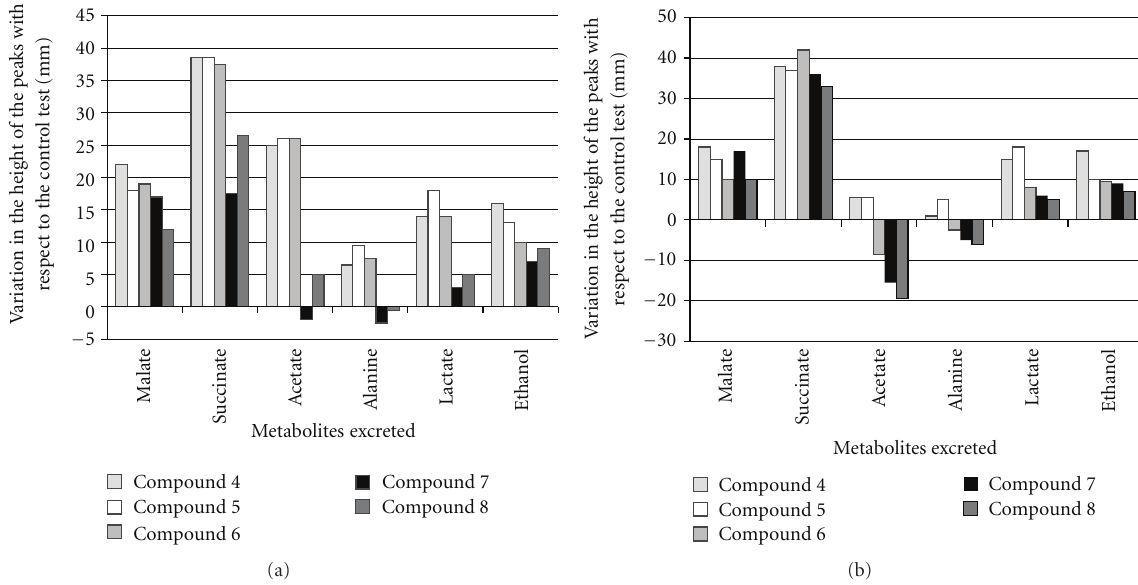
Figure 3: Variation in the height of the peaks corresponding to catabolites excreted by L. infantum (a) and L. braziliensis (b) promastigote forms in the presence of flavonoid derivatives with respect to the control